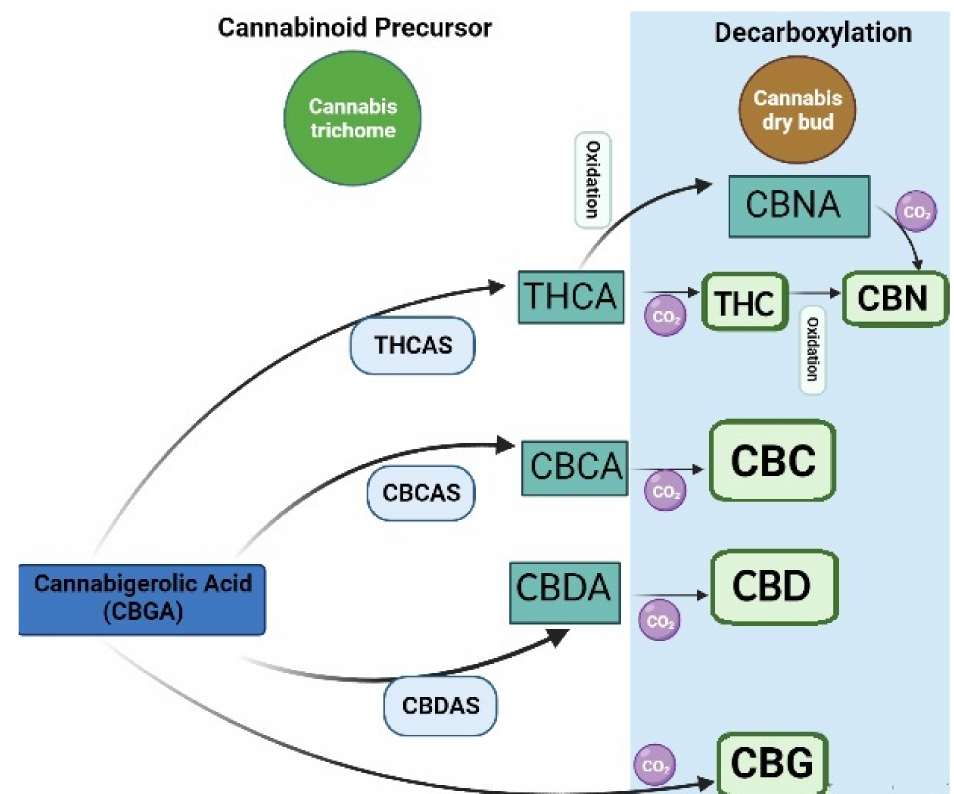
Figure 1. Biosynthesis of cannabinoids: cannabigerolic acid; CBGA, tetrahydrocannabinolic acid synthase; THCAS, cannabidiolic acid synthase; CBDAS, cannabichromene acid synthase; CBCAS, tetrahydrocannabinolic acid, THCA; cannabidiolic acid; CBDA, cannabichromenic acid; CBCA, cannabinolic acid; CBNA, cannabichromene; CBC, cannabidiol; CBD, cannabigerol; CBG, cannabinol; CBN, tetrahydrocannabinol;